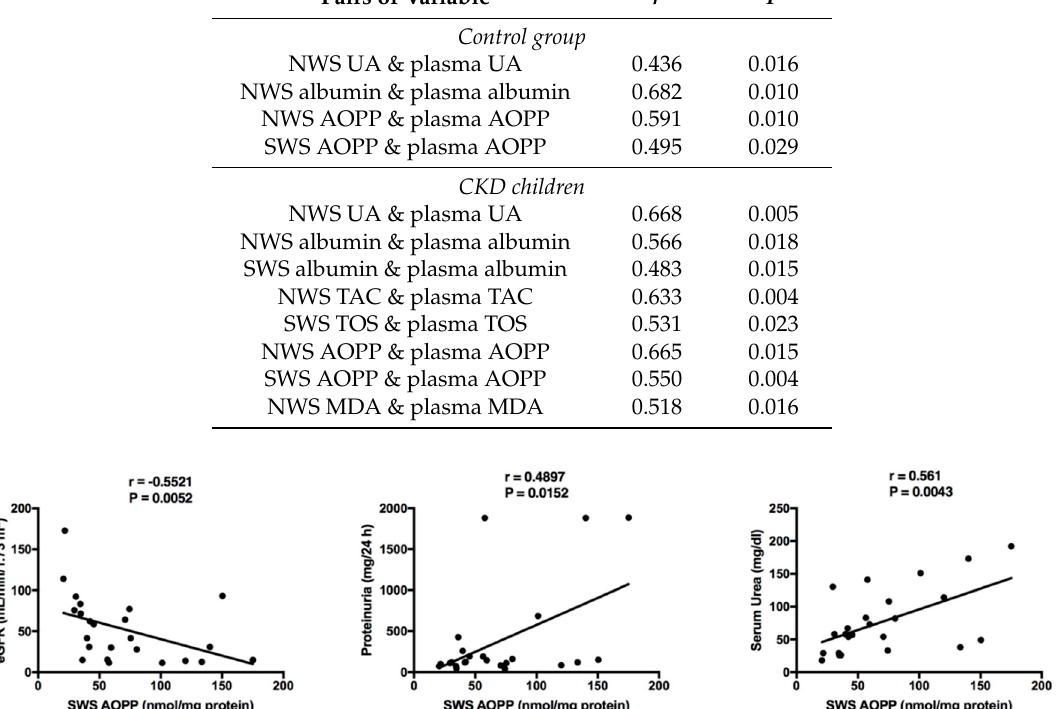
Table 7. Receiver operating characteristic (ROC) analysis of salivary oxidative stress biomarkers of children with chronic kidney disease (CKD) and the controls.